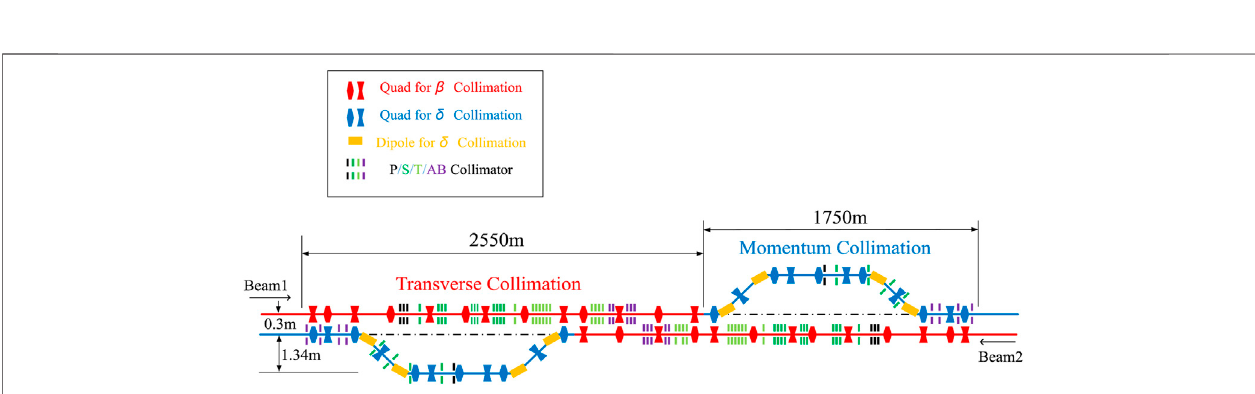
Frontiers in Physics |